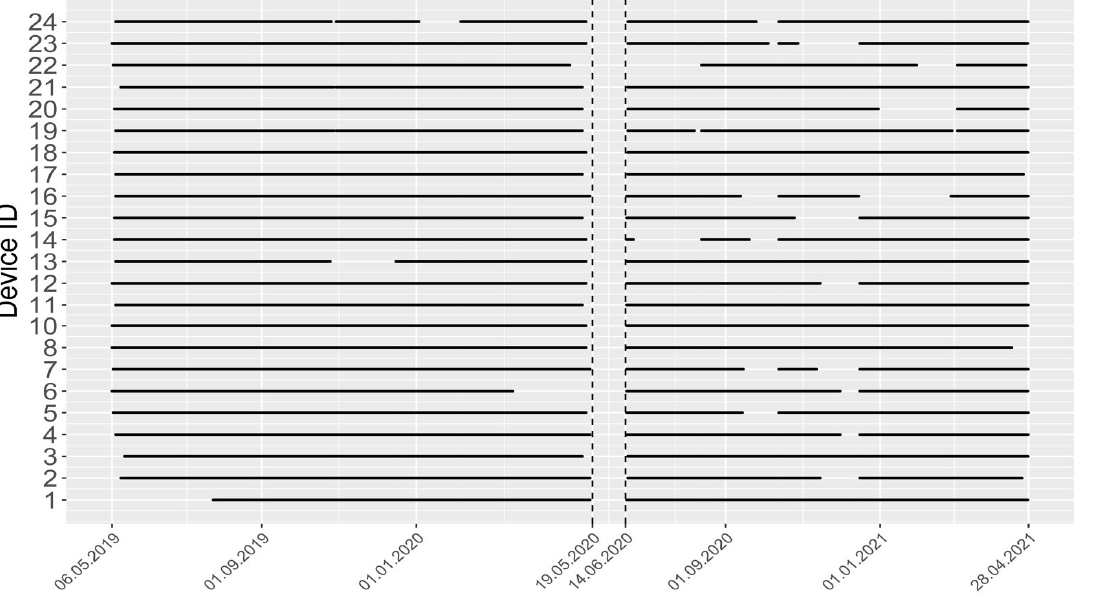
Figure A1. Depicted are the AADs, by their ID, over time on when there are recordings available. Breaks in a line represent a period of missing data. The vertical dotted lines show the maintenance timeframe lasting from 19 May 2020 to 14 June 2020. AAD 9 was excluded from every analysis because of a malfunction.